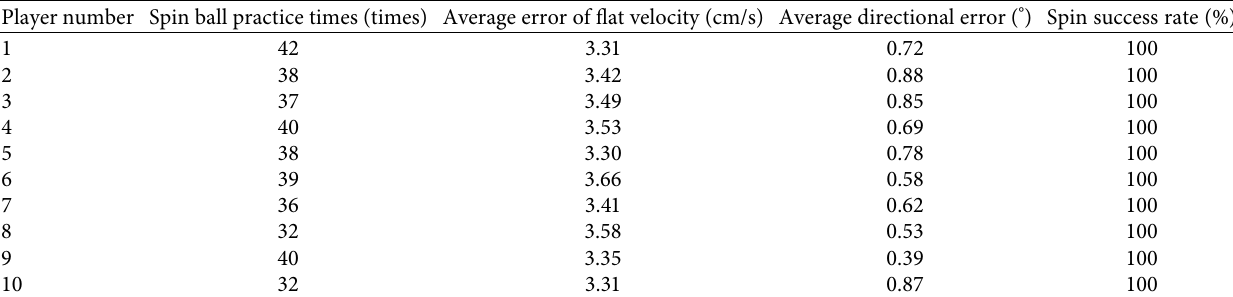
Table 6: Training results of athletes after using this method.